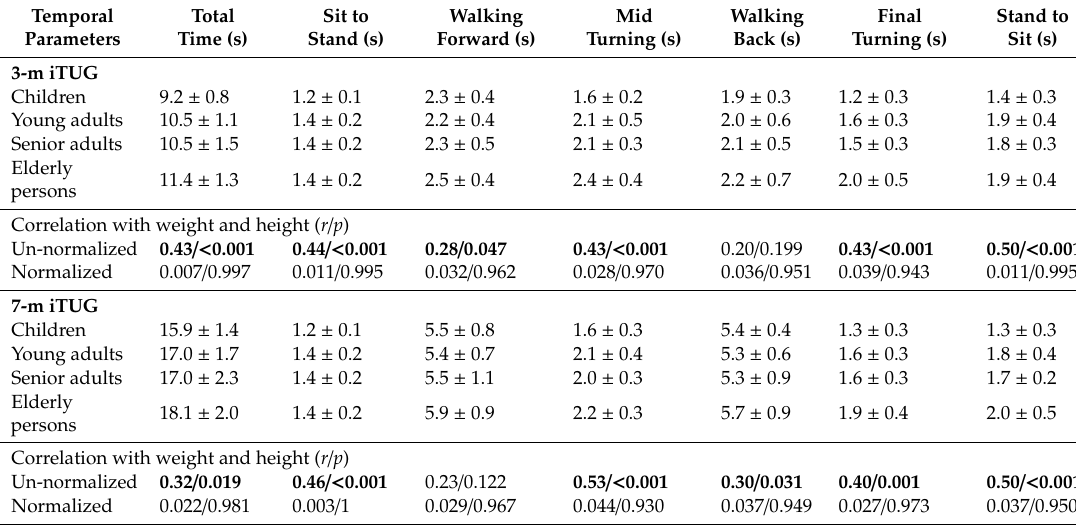
Table 2. Original un-normalized temporal parameters.